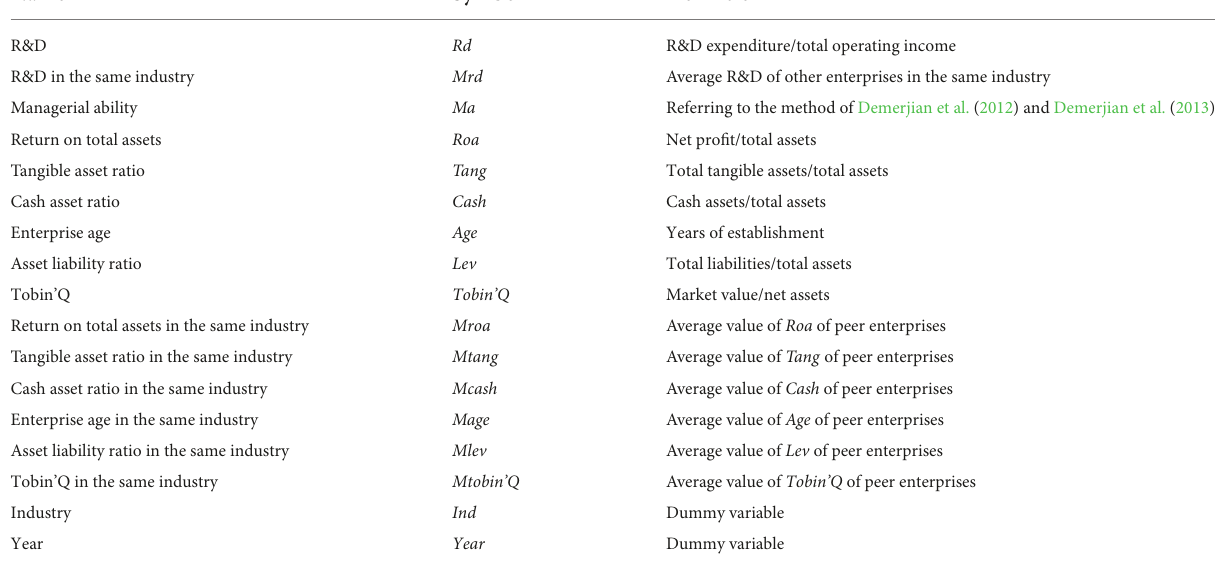
TABLE 1 Definition of